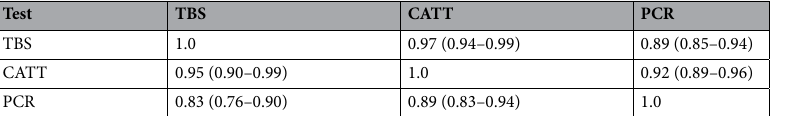
Table 4. Cohen’s kappa (lower) and PABAK (upper) estimates, and 95% confidence interval for the agreement between different tests for detecting T. evansi in 370 dromedary camels. TBS thin blood smear, CATT card agglutination test for T.